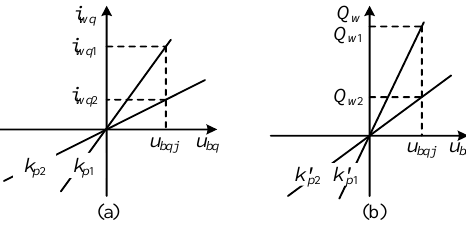
Figure 5. Reactive current and reactive power sharing relationship with the P-type droop control. ( a ) Reactive current sharing relationship; ( b ) reactive power sharing relationship.